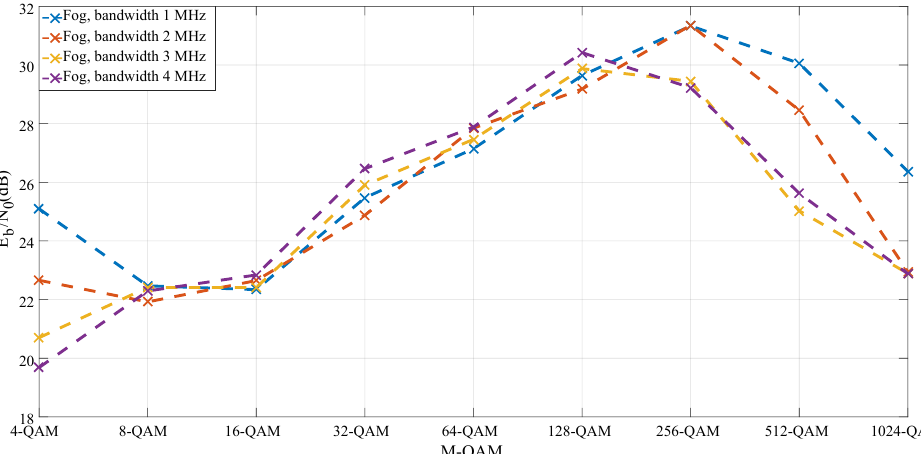
Figure 37. E b /N 0 / distance relationship for Octavia tail-light with different M-QAM and bandwidths —in scenario 5—fog.